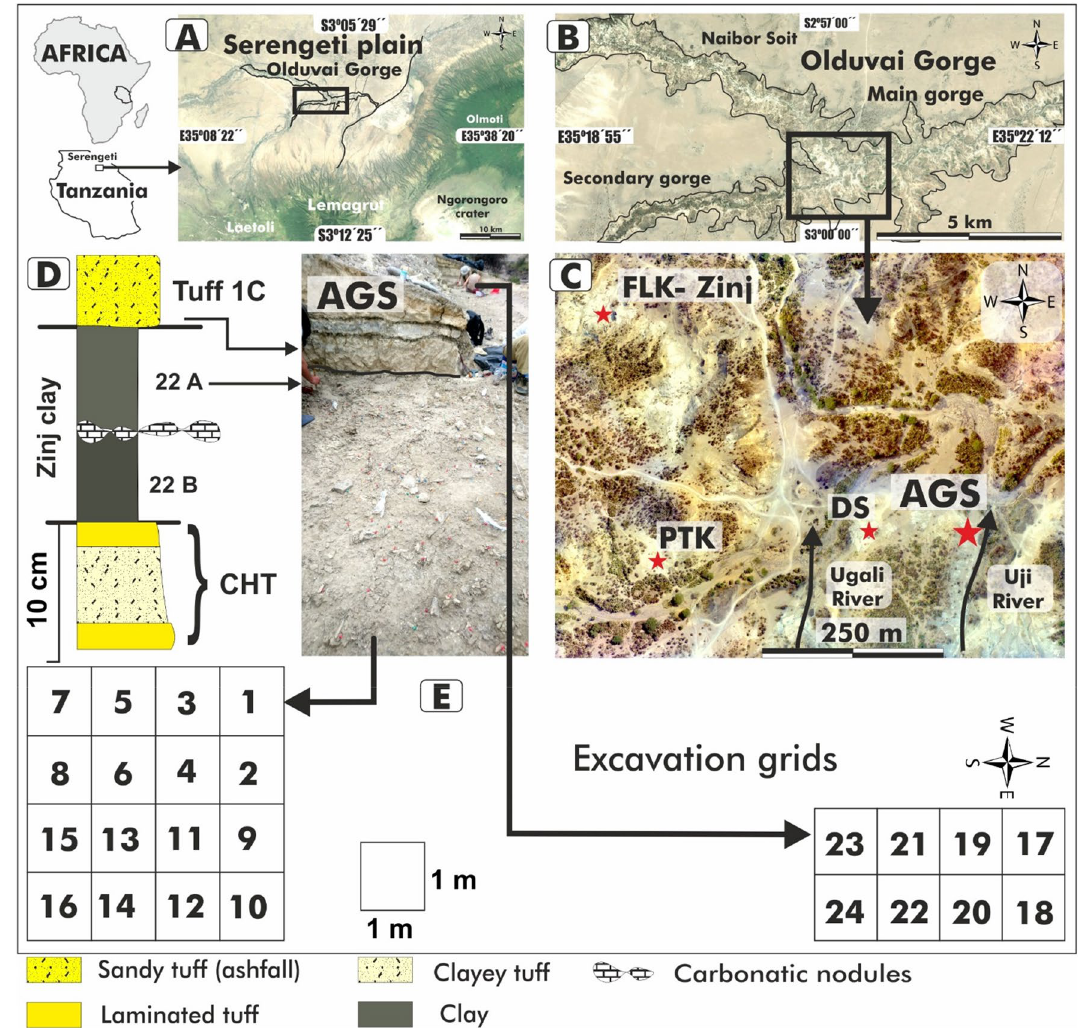
Figure 1. Study area and sample locations at Olduvai Gorge, Tanzania. ( A , B ) Contemporary geographical location of Olduvai Gorge. ( C ) Detailed map of the study area. Red stars indicate archeological sites contemporaneous with the Zinj Paleolandscape. Black arrow lines represent the flow direction of the paleo- rivers Ugali and Uji. ( D ) Stratigraphic section at AGS level 22A, which lies between Chapatti Tuff (CHT) and Tuff 1C. ( E ) Archeological excavation grid at AGS for spatial biomarker reconstructions, including photo of the excavation surface. This figure was made using ArcGis 10.6.1 https:// www. esri. com/ fr- fr/ arcgis/ produ cts/ arcgis- deskt op/ resou